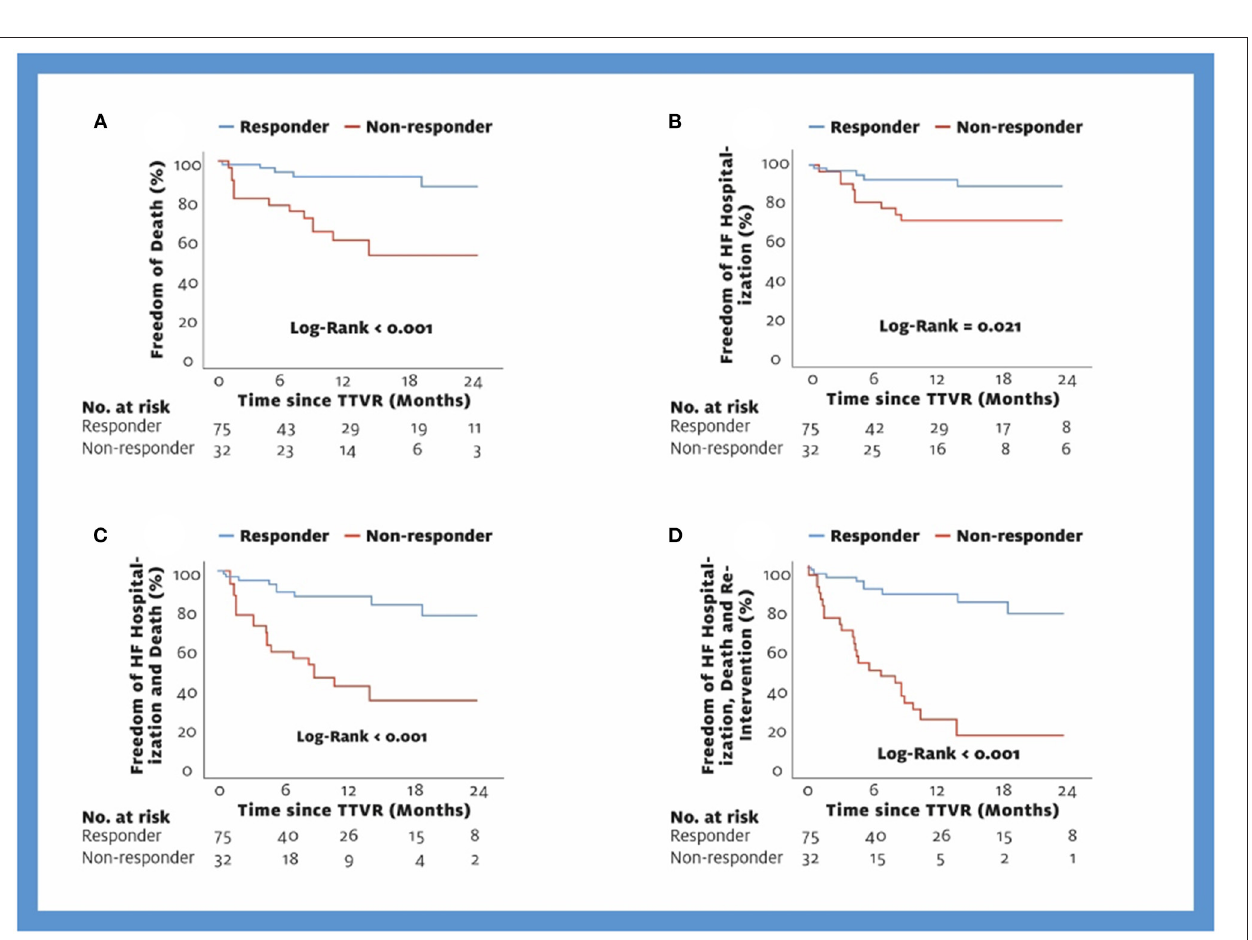
FIGURE 3 | Kaplan-Meier Curves for the endpoints Death (A) , HF hospitalization (B) , Death and HF hospitalization (C) , and Death, HF hospitalization, Re-intervention (D) . TTVR, transcatheter tricuspid valve repair; HF, heart